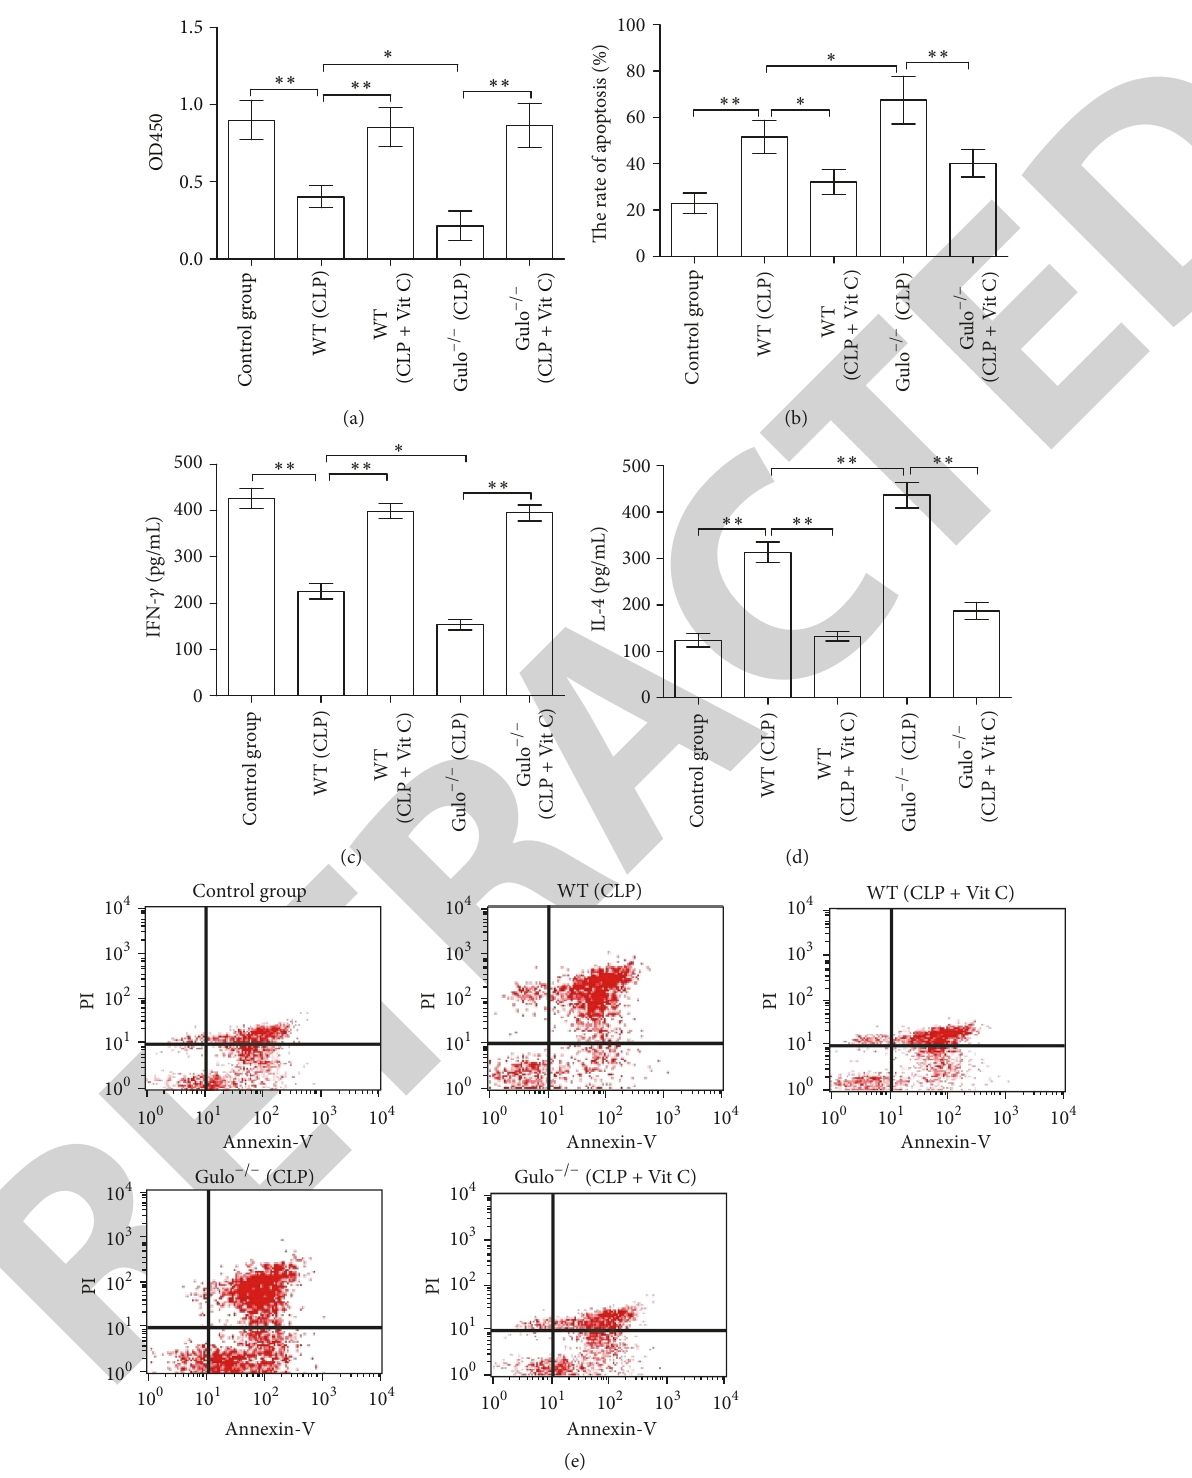
Figure 5: The impact of parenteral Vit C on CD4 + T cells-mediated cellular immunosuppression in sepsis. Treatment with 200mg/Kg par- enteral Vit C upregulated the proliferative response of CD4 + CD25 − T cells of WT mice and Gulo −/− mice in sepsis (a). The apoptotic rate of splenic CD4 + CD25 − T cells was analyzed with Annexin-V-FITC/PI by flow cytometry at 24 hours after CLP-induced midgrade sepsis (e). The apoptotic level of splenic CD4 + CD25 − T cells was decreased when 200mg/Kg parenteral Vit C was administered after CLP to WT mice and Gulo −/− mice in sepsis (b). Parenteral Vit C increased the serum level of IFN- 𝛾 (c) as well as decreasing the serum levels of IL-4 (d) of WT mice and Gulo −/− mice in sepsis. Data were represented as mean ± standard deviation (SD) and analyzed by software SPSS 17.0 with one-way ANOVA, 𝑛 = 4 per group, ∗ 𝑝 < 0.05 or ∗∗ 𝑝 < 0.01